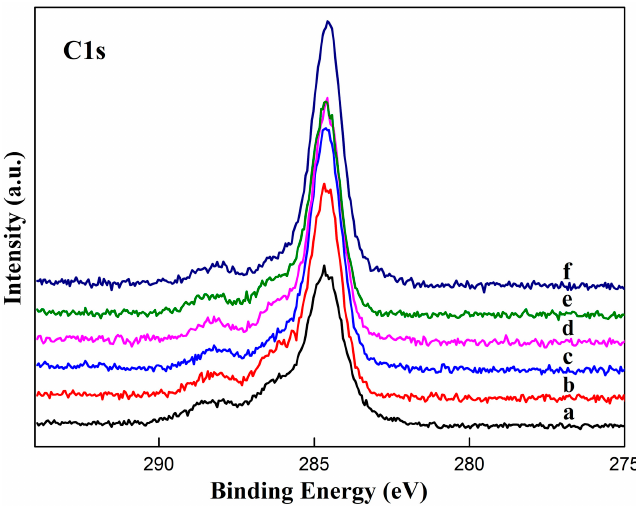
Figure 4. C1s narrow scans XPS spectra of Ni surfaces: ( a ) untreated; ( b ) etched by HCl; ( c ) etched by H 2 SO 4 ; ( d ) etched by H 3 PO 4 ; ( e ) etched by HNO 3 ; and ( f ) etched by HF.